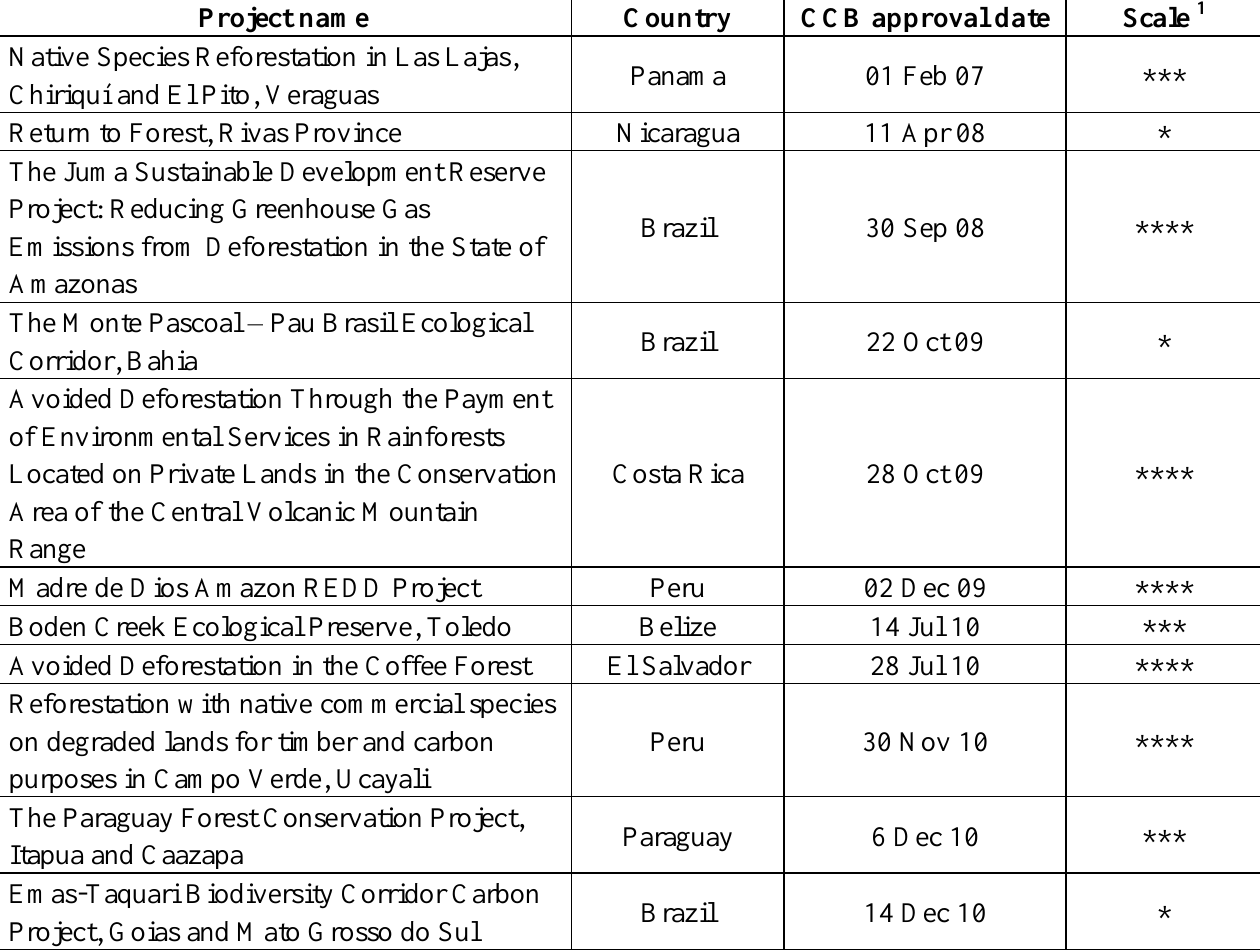
Table 3. Latin American mitigation forestry projects approved by the Climate, Community and Biodiversity Standards as of 28 February 2011